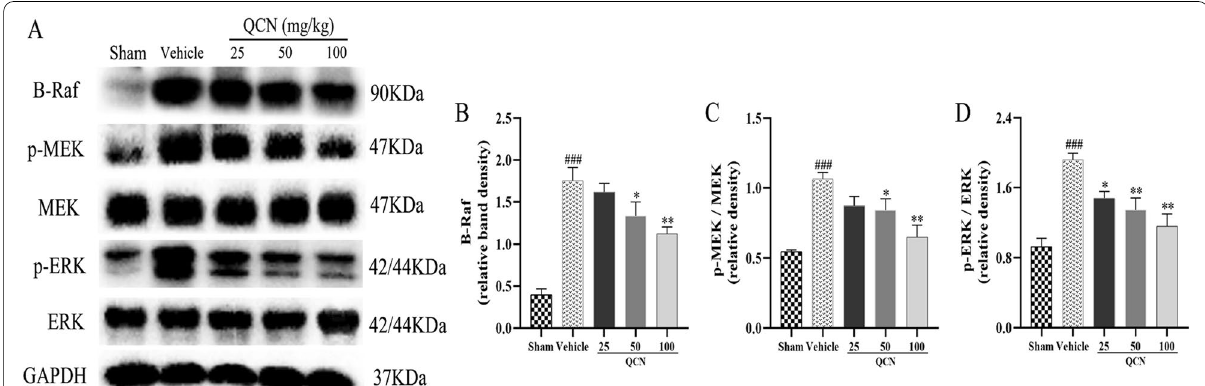
Fig. 8 Effects of QCN on MAPK signaling pathway in the spinal cords of BPA rats at week 8 post‑avulsion. A The protein levels of B‑Raf, p‑MEK and p‑ERK as determined by western blot. Quantification of B B‑Raf, C p‑MEK to MEK, and D p‑ERK to ERK proteins in the ventral horn of the C6‑7 spinal segments. Data are expressed as the mean SEM ( n 3). ### p < 0.001 vs the sham group; * p < 0.05 and ** p < 0.01 vs the vehicle ± =